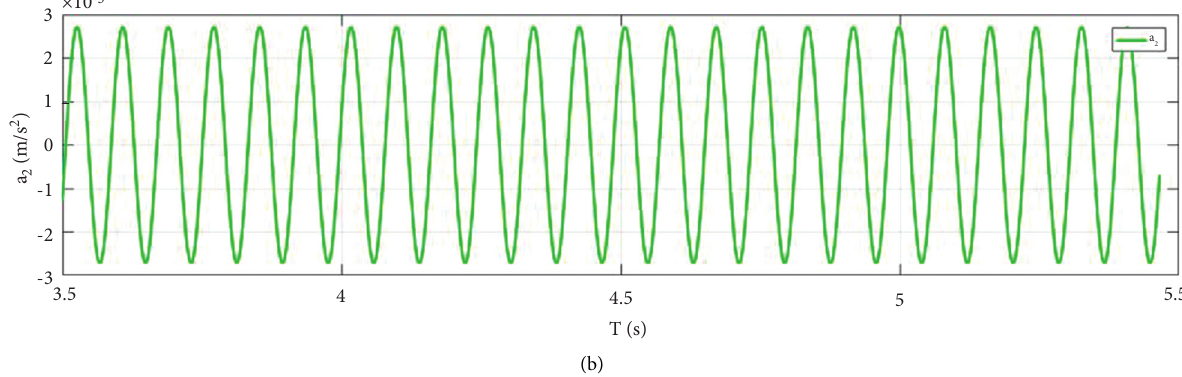
Figure 11: Simulation of vibration suppression of m m 2 acceleration.